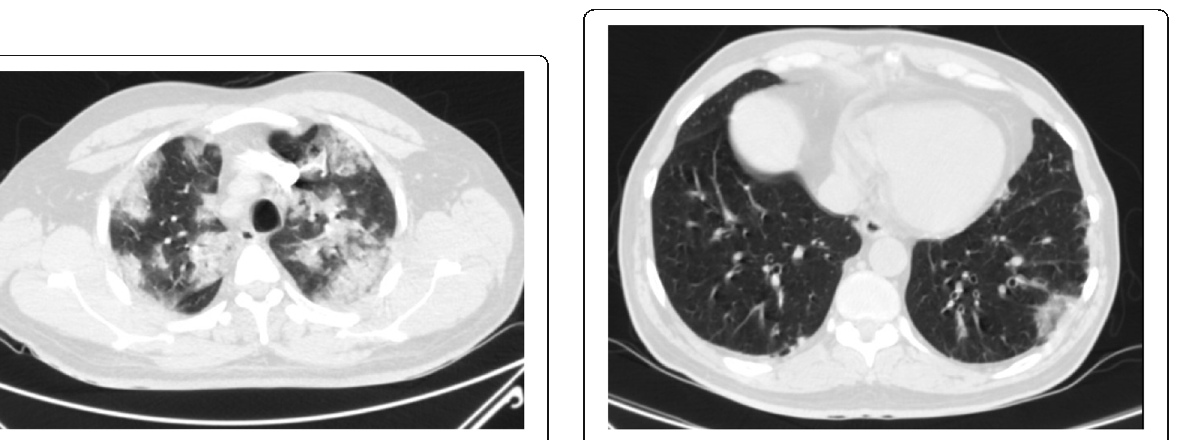
Fig. 5 Influenza A viral infection: thin section CT shows subpleural GGO in left lower